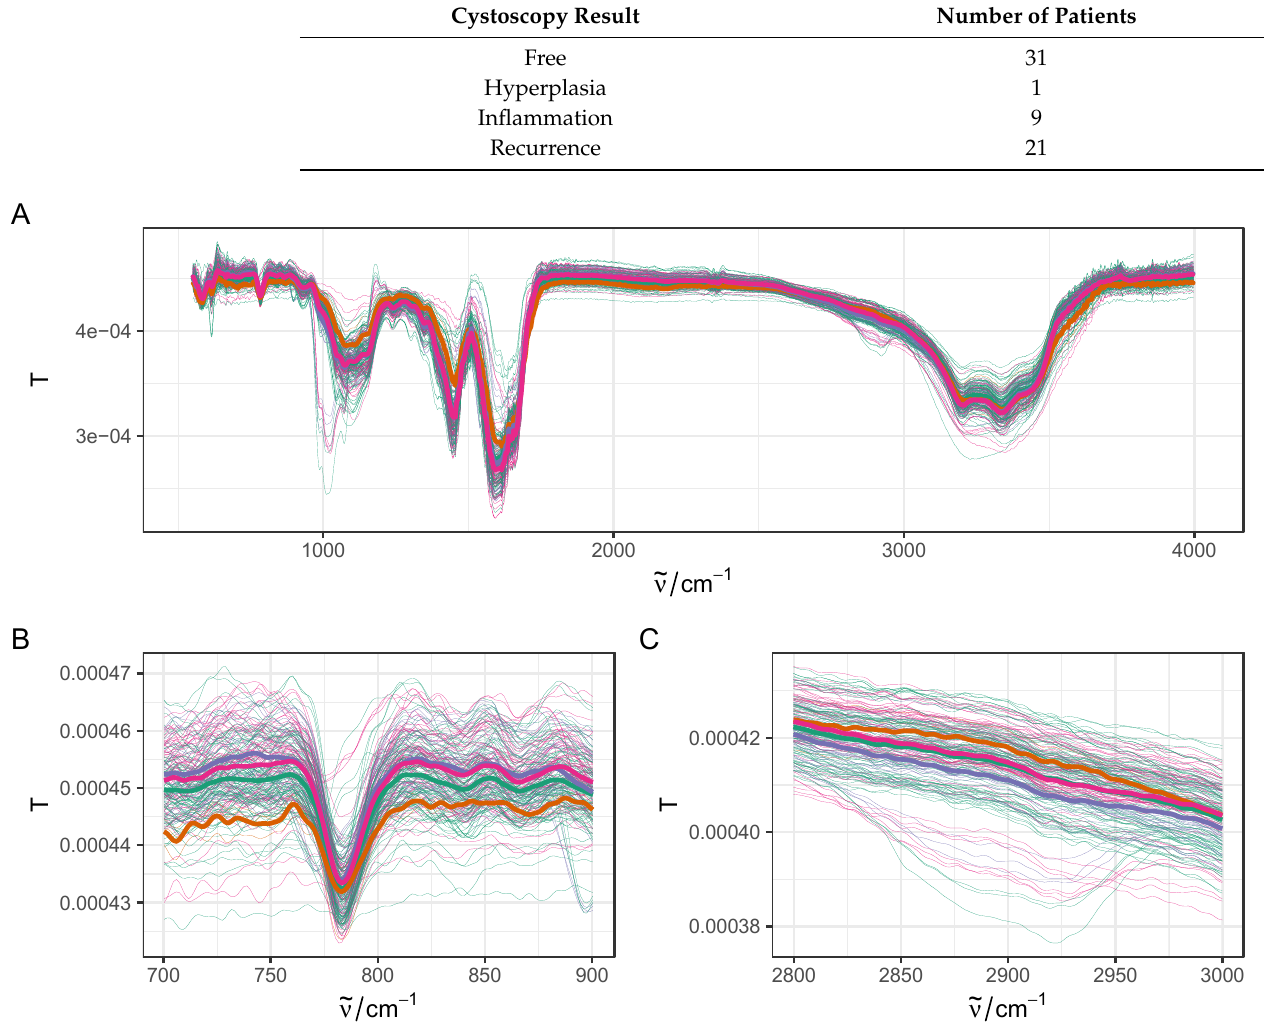
Figure 1. Overview of FTIR dataset (baseline corrected and vector normalized), with full range ( A ), fingerprint region ( B ), and hydrocarbon C-H stretching region ( C ). Bold lines represent average spectra in each group.